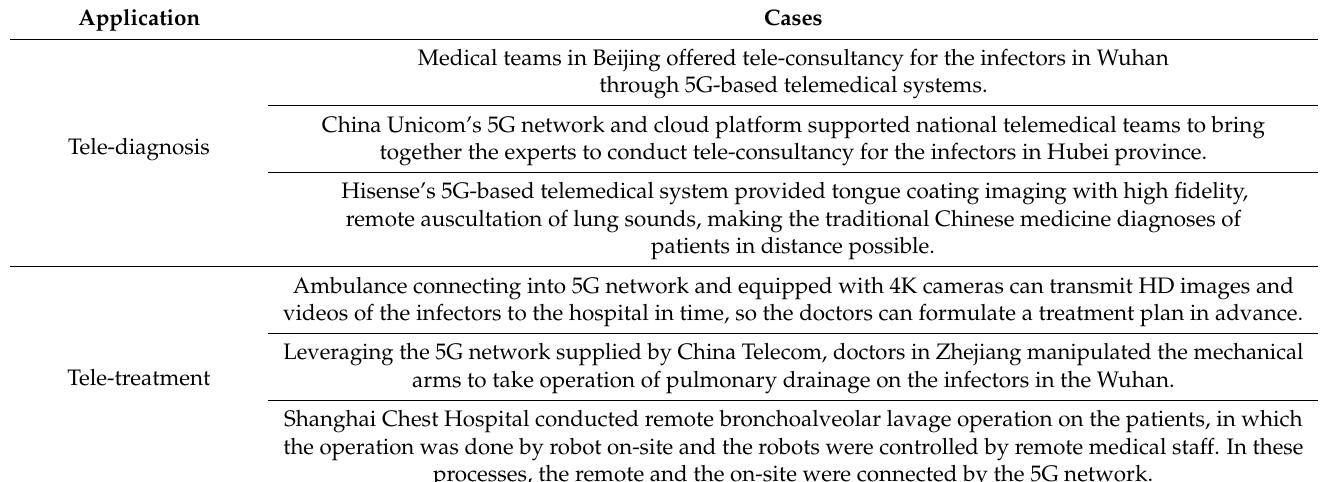
Table 3. The cases in which 5G enabled the diagnosis and treatment of the infectors.